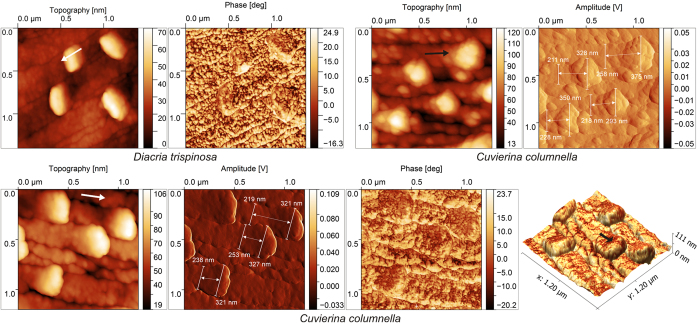
AFM views of the internal growth surfaces of the species indicated.The phase and amplitude views show that the surface texture of the fibres is composed of nanogranules, which are separated by high-contrast interspaces. The texture changes at the tips of the fibres, where granules are coarser and high-contrast interspaces fade out. The marked increase in width from the fibre main bodies to the tips is demonstrated by the measurements provided in the two amplitude views of Cuvierina columnella (top right and bottom central-left panels). In coincidence with the topography images, the 3D reconstruction (bottom right panel) shows how the fibres elevate progressively at the position of the tips. Arrows indicate the growth direction of the fibres. In the 3D reconstruction height is proportional to topography data while the overlay texture comes from the phase data.